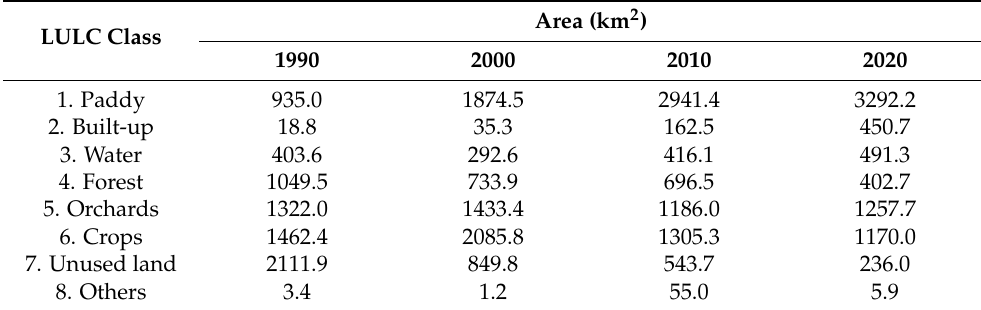
Table 5. The extent of the LULC classes in the Dong Thap Muoi area for the period